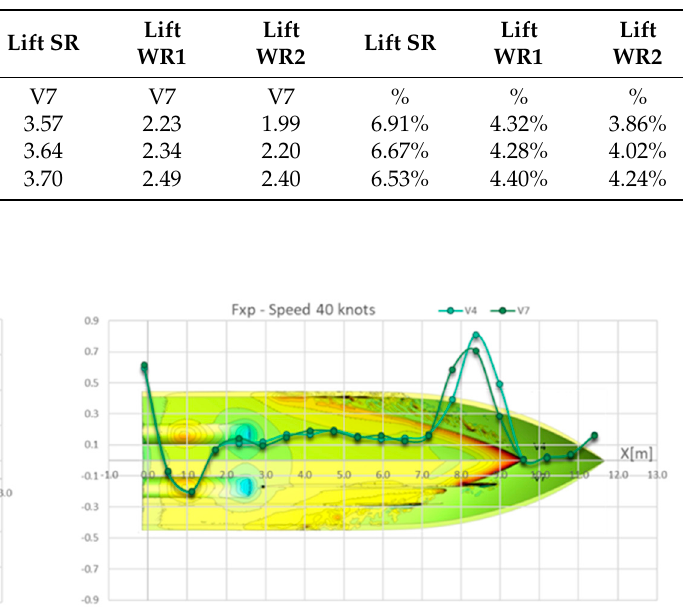
Table 18. Comparison of lift computed on SR and WR.